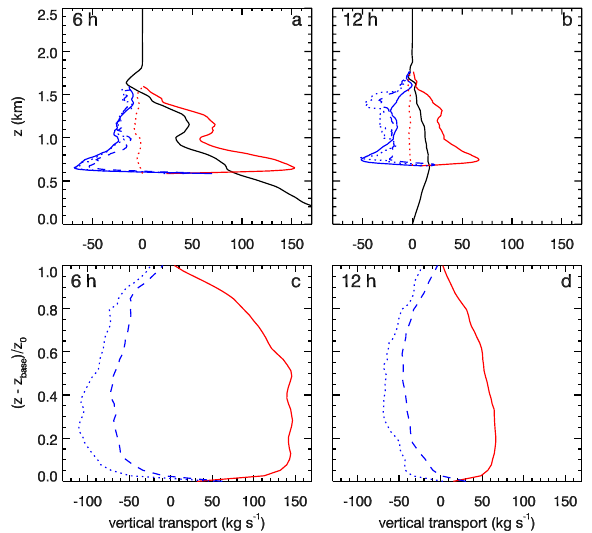
Fig. 2. Sampled profiles of tracer vertical transport at 6h and 12h from case 1. To better illustrate the effect of clouds on the verti- cal transport, we concentrated on cloudy grids (liquid water mixing ratio > 0.01gkg − 1 ) and cloud-free grids here. The black, red, and blue solid lines represent profiles over the whole domain, cloudy grids, and cloud-free grids, respectively. The blue-dotted and blue- dashed lines represent profiles sampled over cloud-free grids within 600m from cloud edges and cloud-free grids within 200m from cloud edges. The red-dotted lines represent profiles sampled over cloudy grids with negative vertical velocity. The downward trans- port in cloudy regions is much weaker than the upward transport in cloudy regions and the downward transport in cloud-free regions, as will be discussed in more detail in Fig. 7. In (a) and (b) , profiles are plotted with respect to height. In (c) and (d) , transport related to each cloud is non-dimensionalized with respect to the depth ( z 0 ) of that cloud. Note that clouds with cloud base higher than 1400 m are not included in the non-dimensionalized